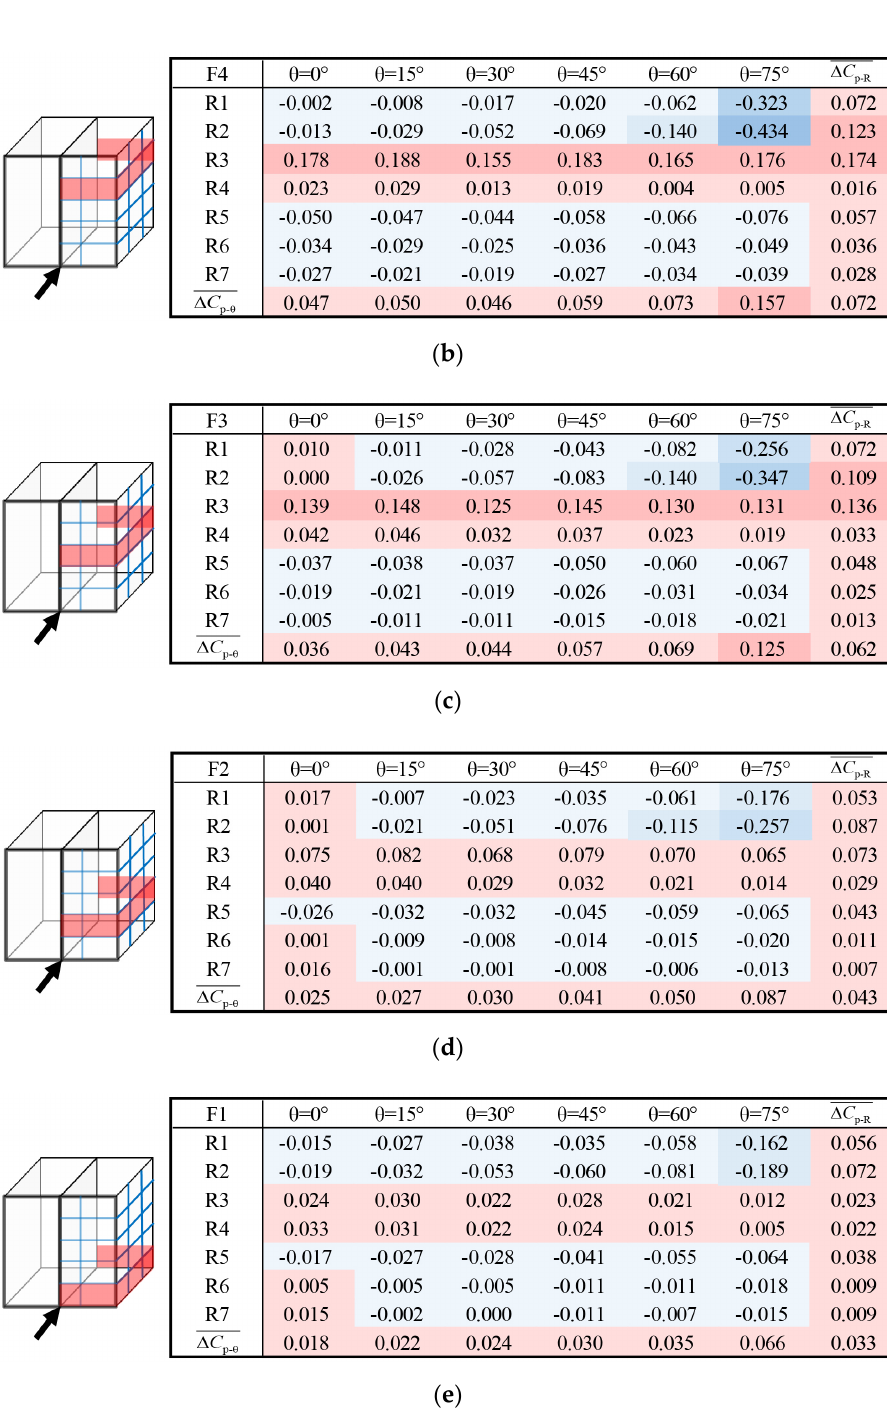
Figure 16. Di ff erence ∆ C p of average wind pressure coe ffi cient C p between di ff erent shaded conditions and the non-shaded condition for ( a ) F5; ( b ) F4; ( c ) F3; ( d ) F2; ( e ) F1.